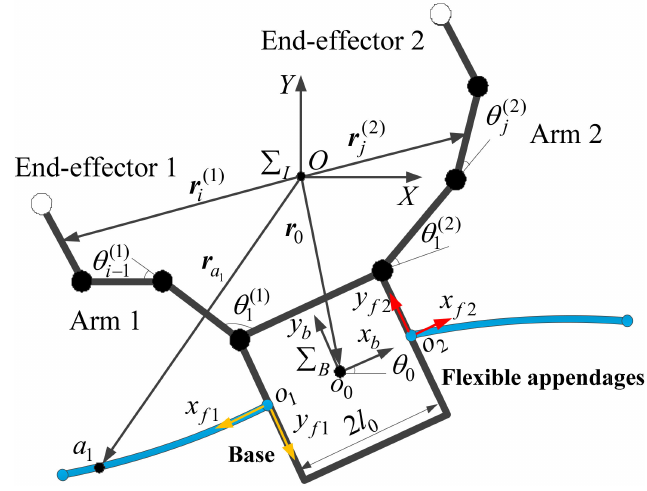
Figure 2. A dual-arm space robot with flexible